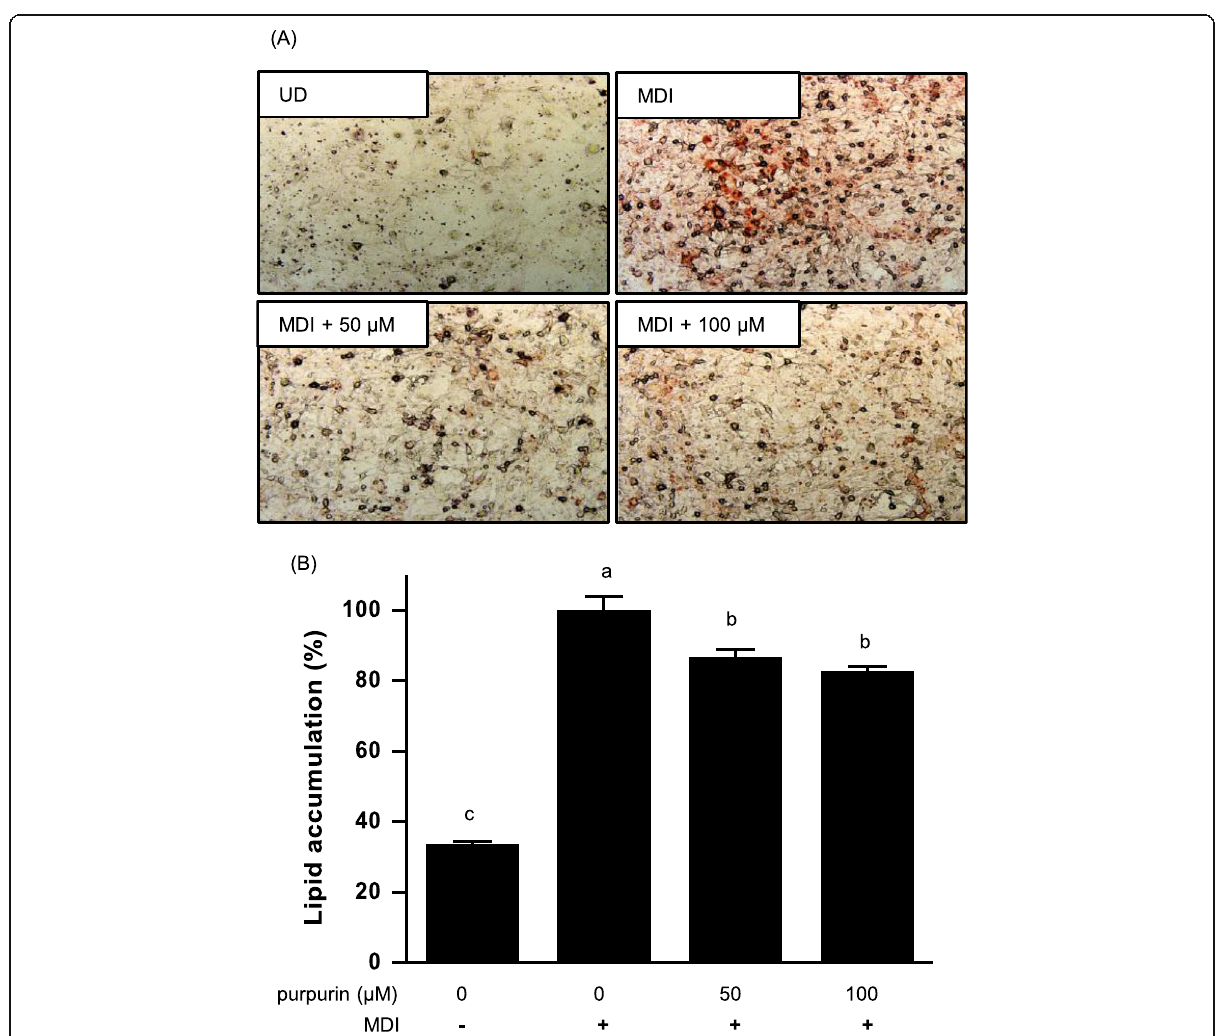
Fig. 6 Effect of purpurin on lipid accumulation in differentiated 3T3-L1 cells as measured with Oil Red O staining. The accumulation of lipid was evaluated: a microscopically; and ( b ) colorimetrically (absorbance at 520 nm) from solubilized fat droplets collected from the stained cells. Data are expressed as the mean ± SD of triplicate experiments. Bars sharing a common letter are not significantly different at p <